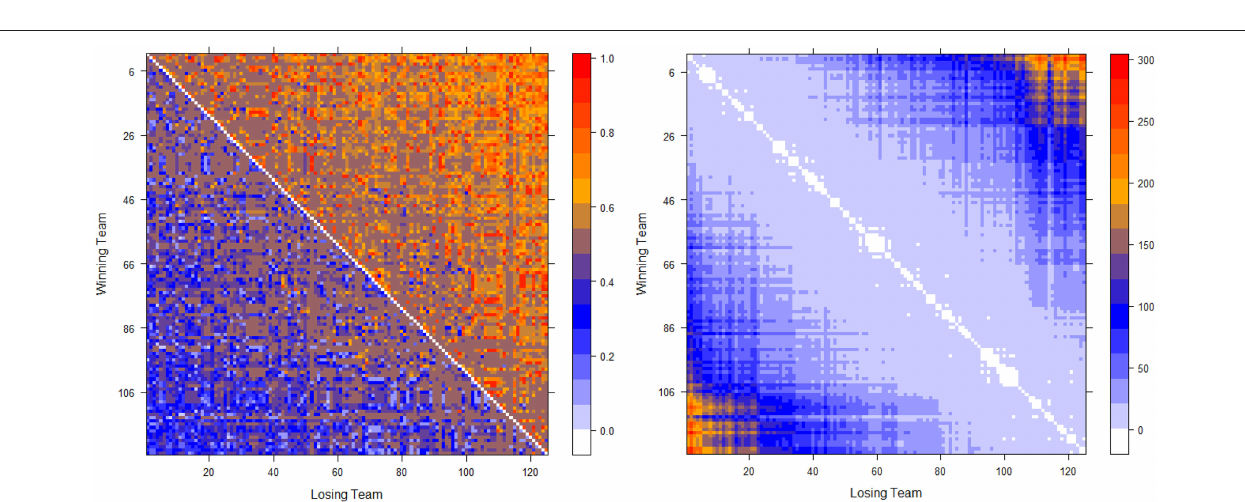
FIGURE 3 | Optimally permuted ˆ P D ( W 0 ) (left panel) and Hamiltonian distance matrix with teams being arranged according to ˆ σ * for the 2013 NCAA football season (right